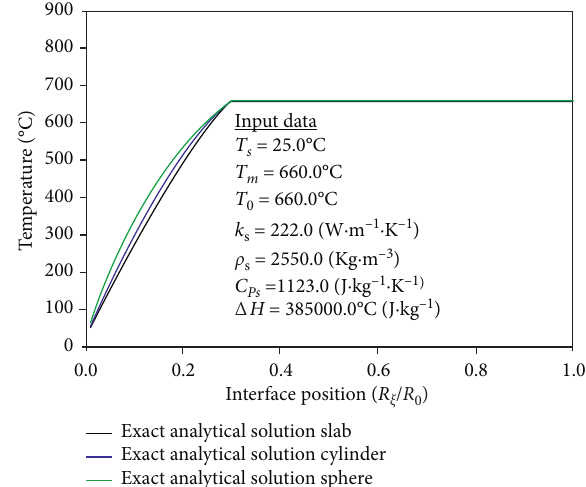
Figure 11: Comparison of concentration profiles during inward one-phase solidification of a slab, a cylinder, and a sphere as a function of dimensionless position ( R